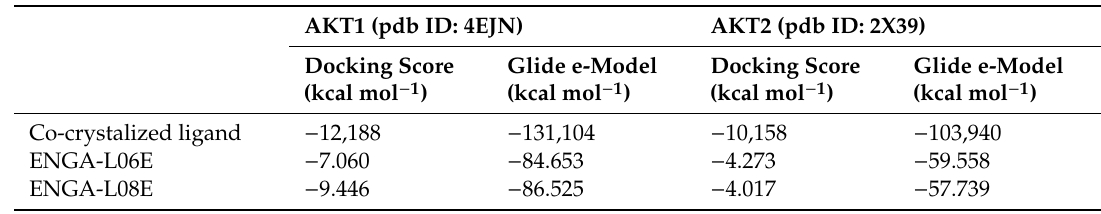
Table A7. Docking scores and Glide e-model in kcal / mol of molecules ENGA-L06E and ENGA-L08E compared to the co-crystal ligand in proteins AKT-1 and